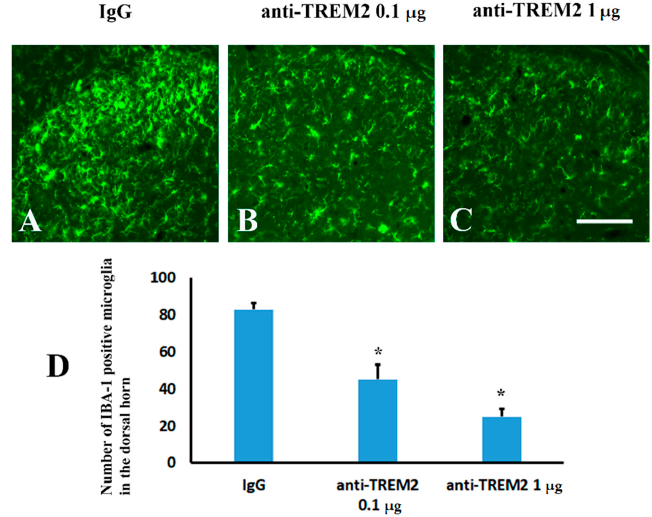
Figure 7. Functional blockage of TREM2 attenuated inflammatory response of spinal microglia induce by peripheral nerve ligation. ( A ): IgG. ( B ): anti-TREM2 at a dose of 0.1 µ g. ( C ): anti-TREM2 at a dose of 1 µ g. ( D ): Quantification of Iba1positive microglia in the ipsilateral dorsal horn following TREM2 antibody treatment in the mice following peripheral nerve injury. * p < 0.05 vs. IgG group. Scale bar, 150 µ m.